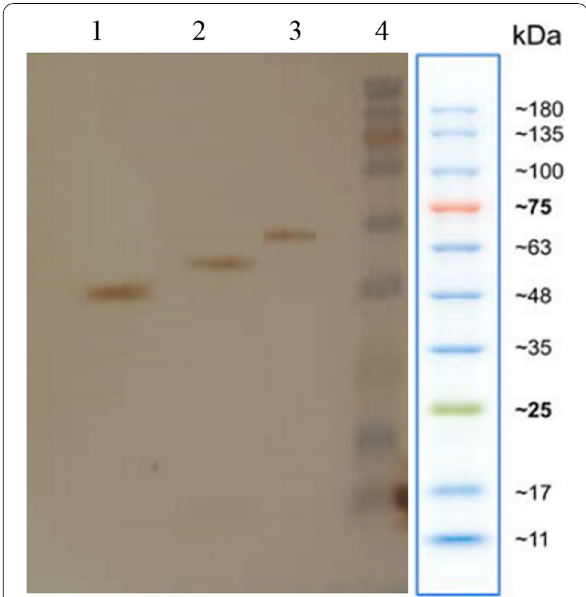
Fig. 2 Western blot analysis of full-length and truncated forms of seHAS expressed in recombinant Bacillus strains (Lane 1: Tr3, Lane 2: Tr4, Lane 3: seHAS, and Lane 4: Protein ladder)